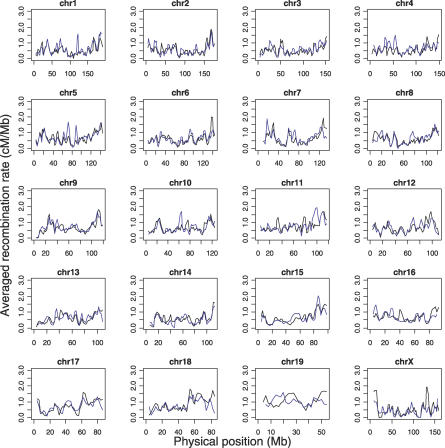
Average Recombination Rates for All ChromosomesRates for RIs are shown as a black line and for HS as a blue line. The ratio between the genetic distance and physical distance was calculated using a sliding window of 5 Mb and a shift of 2 Mb between windows centers, assuming a constant rate of recombination between two adjacent markers.